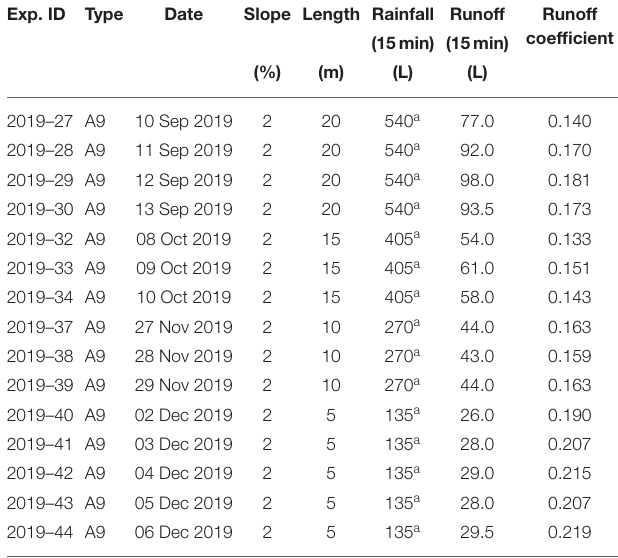
TABLE 3 | Artificial rainfall experiments carried out in 2019 with 2%